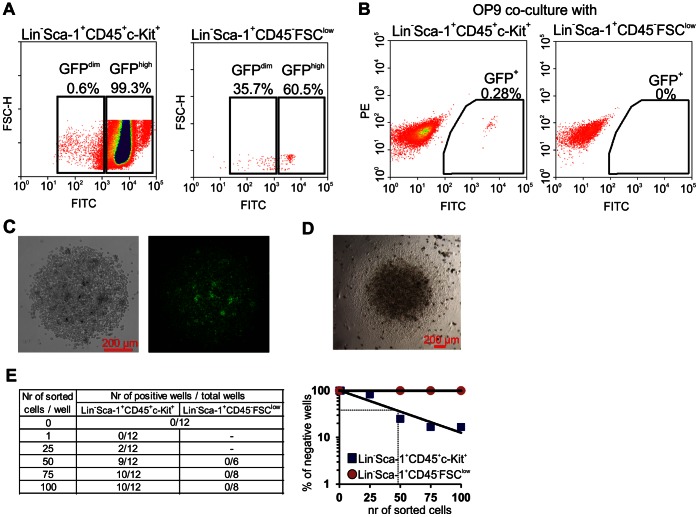
Hematopoietic differentiation of Lin−Sca-1+CD45−FSClow and Lin−Sca-1+CD45+c-Kit+ cells after OP9 co-culture.(A) Lin−Sca-1+CD45−FSClow isolated from the BM of C57BL/6-Tg(UBC-GFP)30Scha/J mice presented lower GFP expression comparing to Lin−Sca-1+CD45+c-Kit+ cells from this mouse strain. (B) Lin−Sca-1+CD45−FSClow isolated from the C57BL/6-Tg(UBC-GFP)30Scha/J mice lost GFP expression after 4 days co-culture with OP9 cells. In contrast, Lin−Sca-1+CD45+c-Kit+ sustained GFP expression after the co-culture. (C) Representative colony formed by single Lin−Sca-1+CD45+c-Kit+cell that was sorted from co-culture with OP9. (D) Representative colony formed by single Lin−Sca-1+CD45+c-Kit+ co-cultred with OP9 after transferring to hematopoietic differentiation media. (E) Limiting dilution analysis of colony forming cells among Lin−Sca-1+CD45−FSClow and Lin−Sca-1+CD45+c-Kit+ co-cultured with OP9 cells.